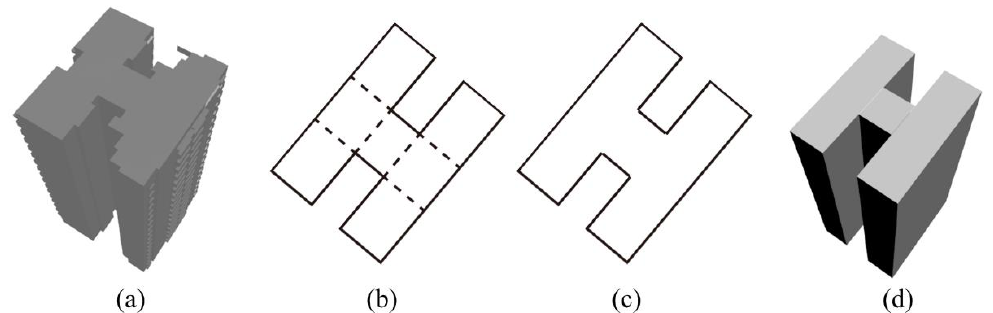
Figure 5. The extraction of representative edges from a 3D building owning one roof height: ( a ) the original 3D building; ( b ) the extracted edges (representative edges: solid lines; normal edges: dashed lines); ( c ) the representative edges; and ( d ) the reconstructed watertight 3D building.